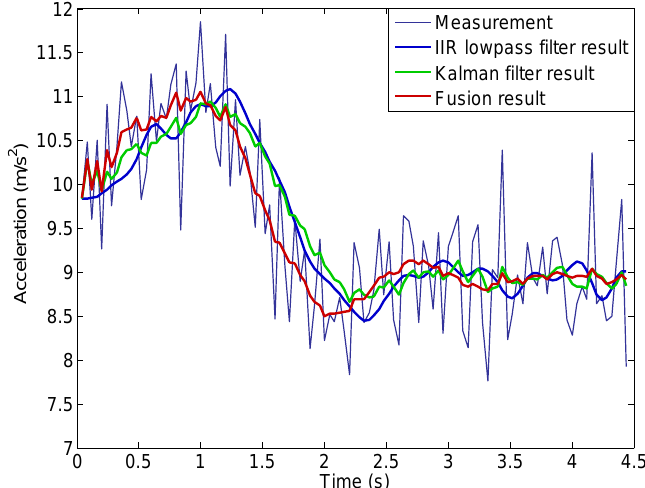
Figure 16. Acceleration fusion result compared with the IIR lowpass filter and Kalman filter